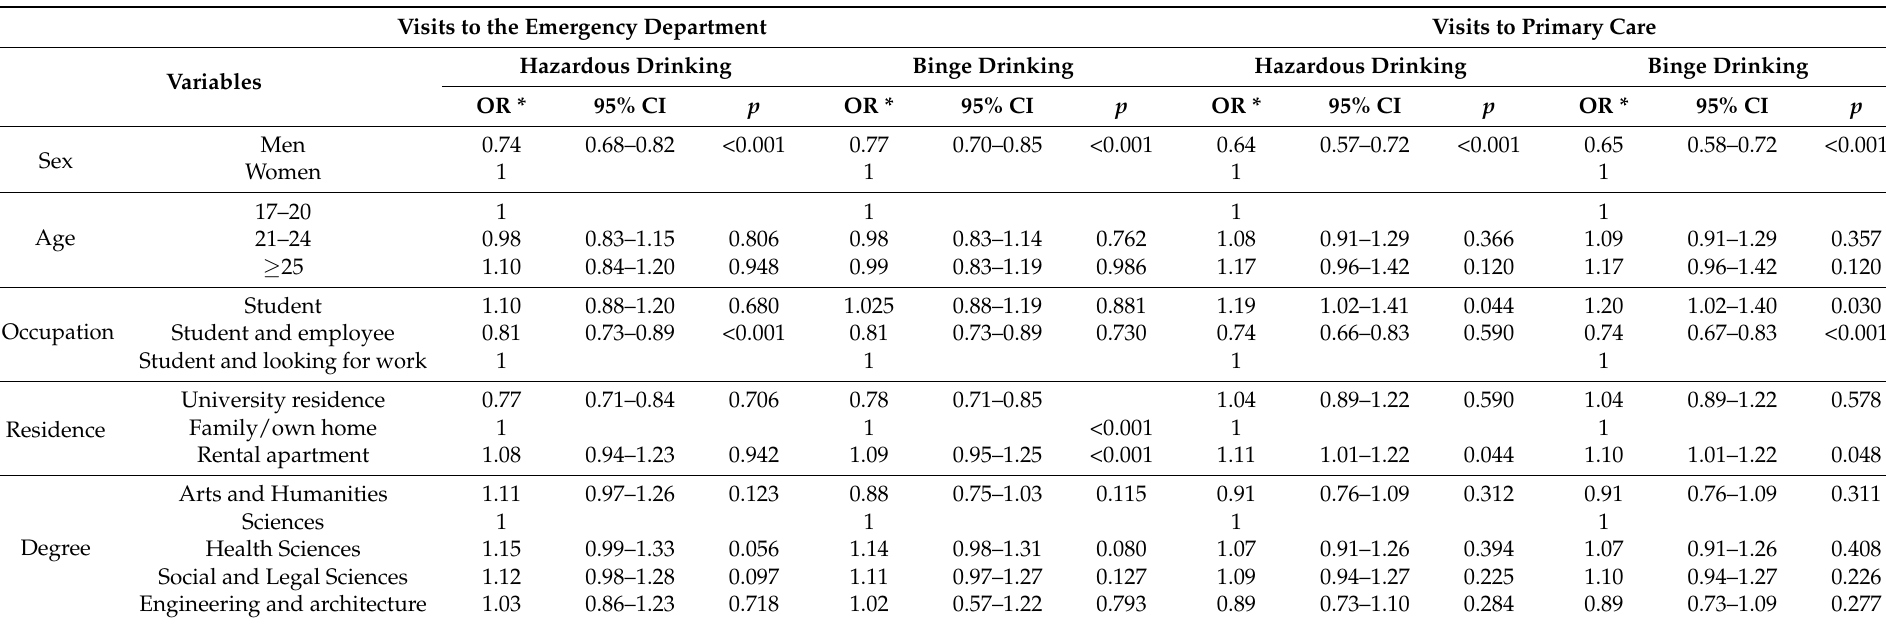
Table 6. Factors associated with the use of health services according to the pattern of alcohol consumption: logistic regression